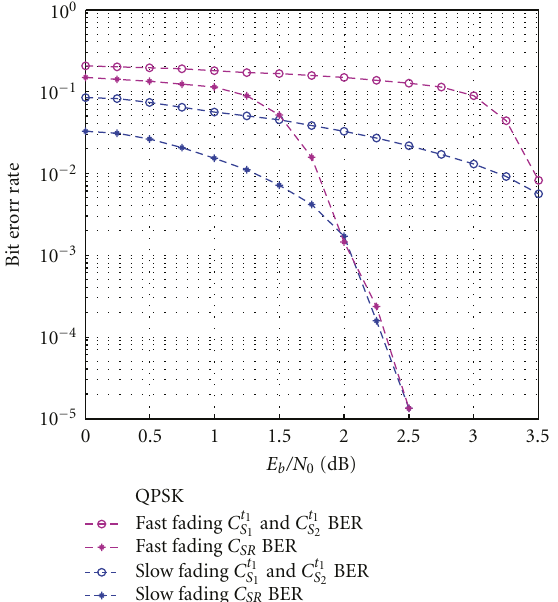
Figure 12: The BER performance under the Rayleigh Fading channel with QPSK, d = 0 . 5, and R t 1